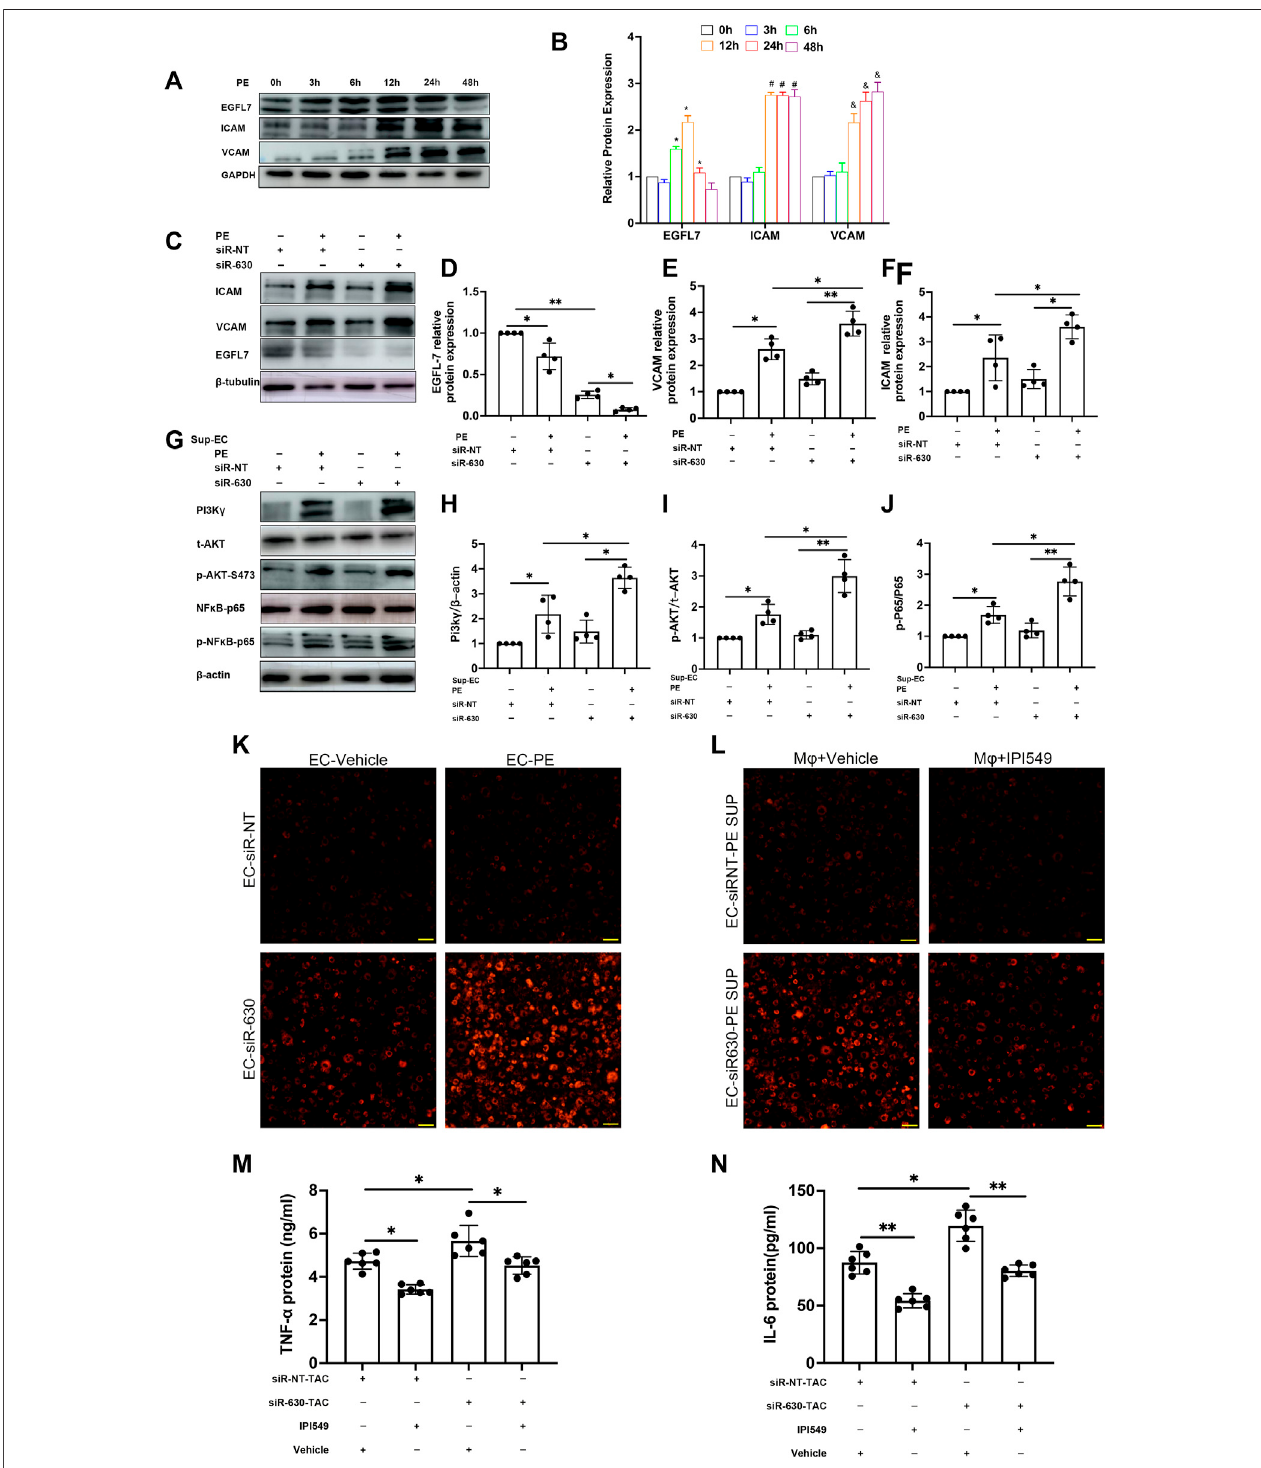
FIGURE 4 | EGFL7 KD upregulated adhesion cytokines in ECs and activated macrophages through PI3K γ /AKT/NF κ B signaling. (A) MAEC was stimulated by phenylephrine (PE, 100 μ M) for multiple time points. representative immunoblots of EGFL7, ICAM, VCAM, and quantitative analysis (B) , these proteins ’ relative expressionwasnormalizedtoGAPDH(* p < 0.05vs.0 hinEGFL7,# p < 0.05vs.0 hinICAM,and p < 0.05vs.0 hinVCAMbyone-wayANOVAfollowedbyTukey ’ stest). (C) MAEC wastransfected withsiRNA-630orsiRNA-NT.RepresentativeimmunoblotsofEGFL7, ICAM,VCAM inMAECs treatedwithphenylephrine(PE,100 μ M, 24 h) after transfected with siRNA-630 or siRNA-NT. (D – F) quantitative analysis of EGFL7, ICAM, VCAM (* p < 0.05,** p < 0.01 by one-way ANOVA followed by Tukey ’ s